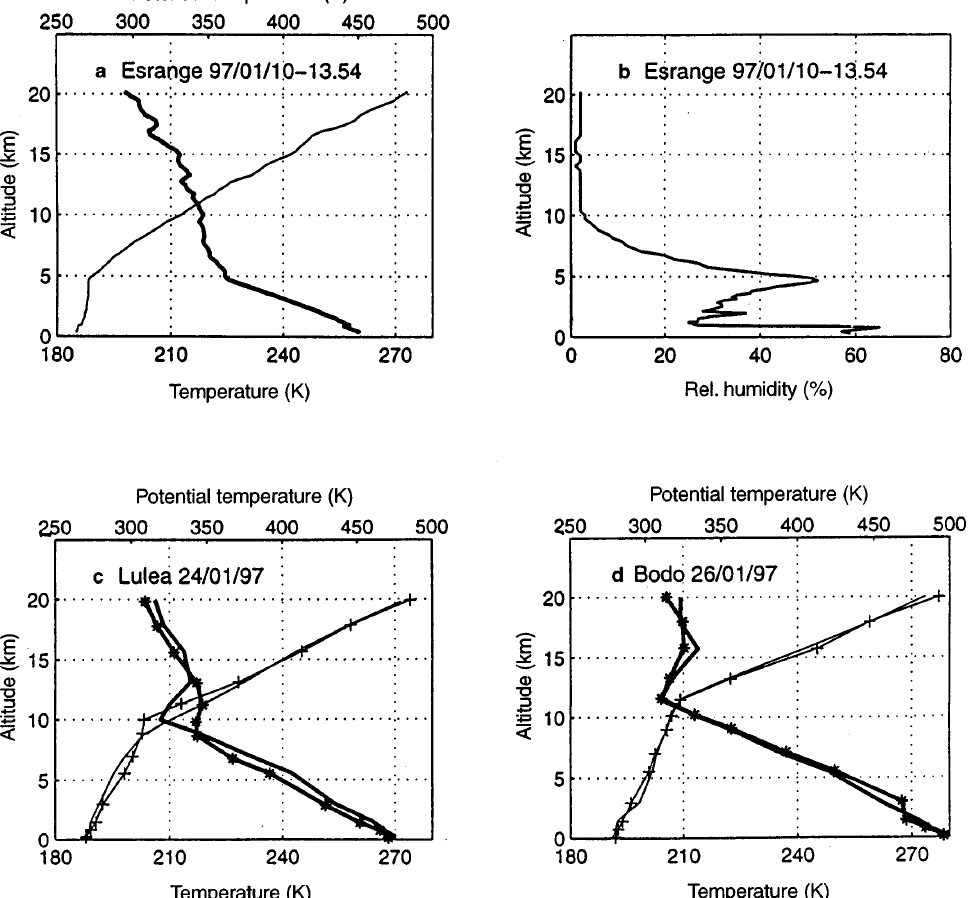
Fig. 5. Radiosonde data a from Esrange showing temperature ( thick line ) and potential temperature ( thin line ) and b humidity for 10 January, c from Lulea showing temperature (0 UT: thick line ; 12 UT: –*) and potential temperature for 0 UT ( thin line ) and 12 UT ( (cid:6) )